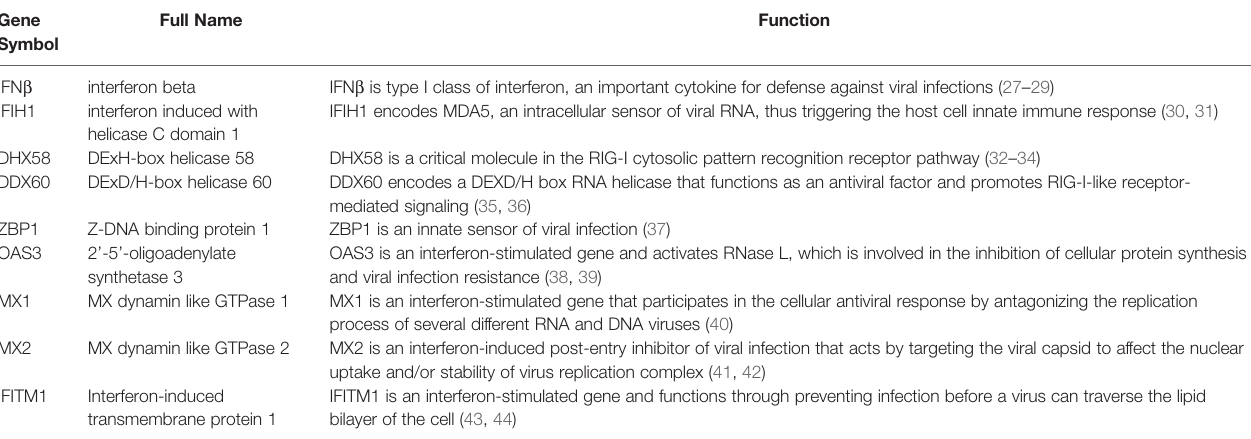
TABLE 1 | Viral infection-associated innate immune molecules.